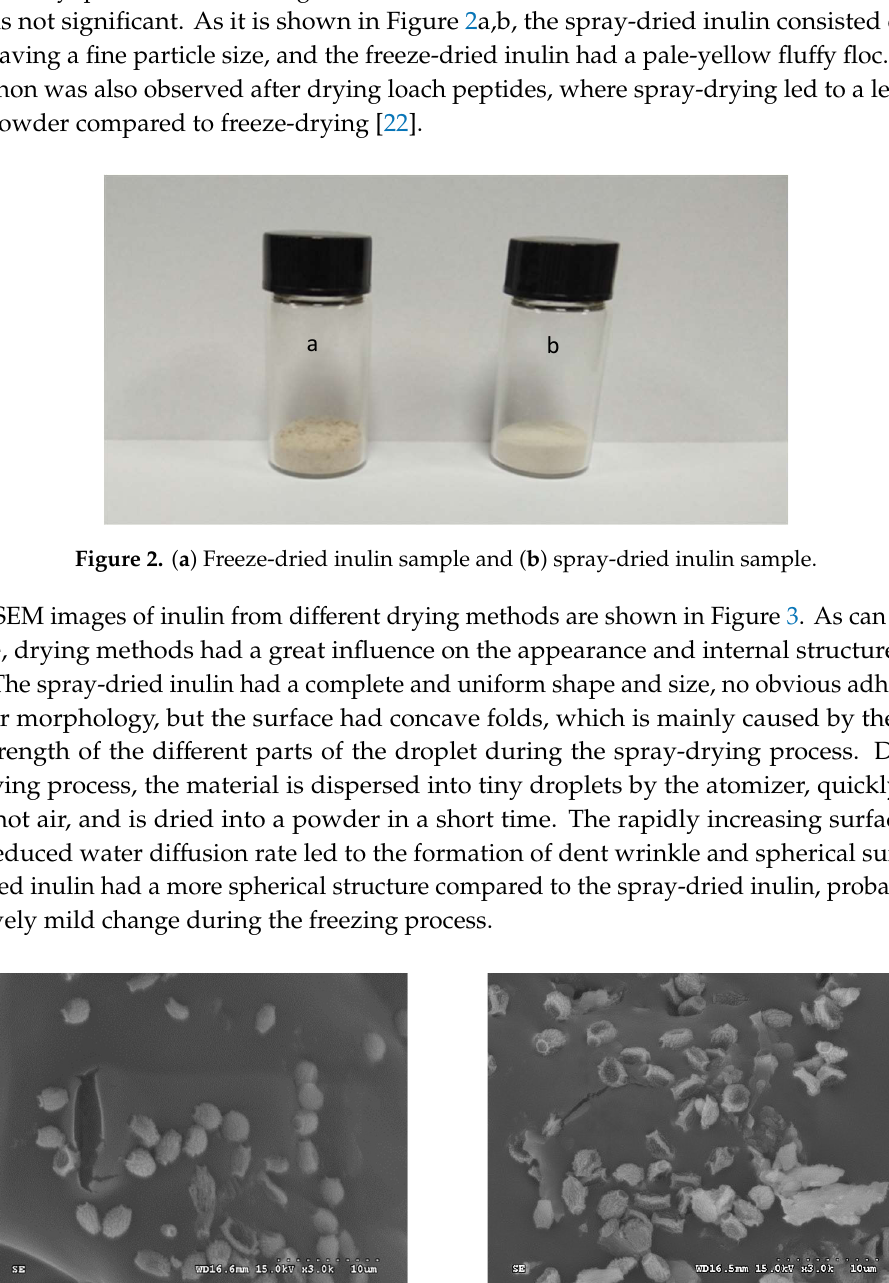
Table 3. Effect of drying method on inulin.